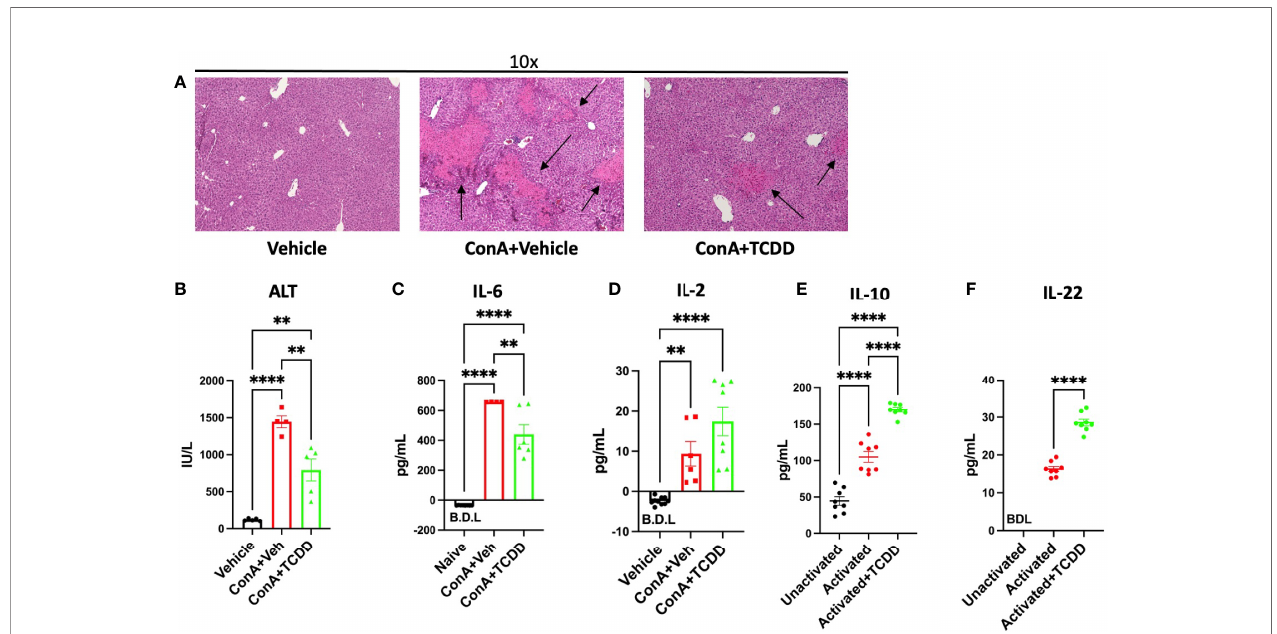
FIGURE 1 | Treatment with TCDD ameliorates ConA-induced liver Injury. C57/BL6 mice were injected with ConA followed by vehicle or TCDD 1 hour later as described in Methods. After 24 hours, livers were perfused, sectioned, and stained with H&E and serum from blood collected. (A) Histopathological analysis shows in fi ltrating cells in the liver of ConA-treated mice when compared to the vehicle controls and TCDD treated group showing decreased in fi ltration of cells. Damaged areas are indicated by arrows (B) ALT levels in serum. (C) IL-6 levels and (D) IL-2 levels in the serum measured by ELISA. (E) Splenocytes were activated in vitro with ConA and exposed to TCDD, and the culture supernatants were assayed for IL-10 or (F) IL-22 by ELISA. Signi fi cance was determined by one-way ANOVA followed by Tukey ’ s posthoc test. Vertical bars represent Mean +/- SEM. **p < 0.01, ****p <